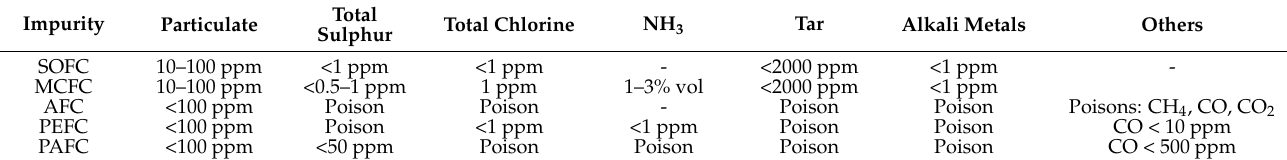
Table 5. Requirements for syngas utilizations in a solid oxide fuel cell (SOFC) and comparison with other fuel cells MCFC (molten carbonate fuel cell), AFC (alkaline fuel cell), PEFC (polymer electrolyte fuel cell) and PAFC (phosphoric acid fuel cell)